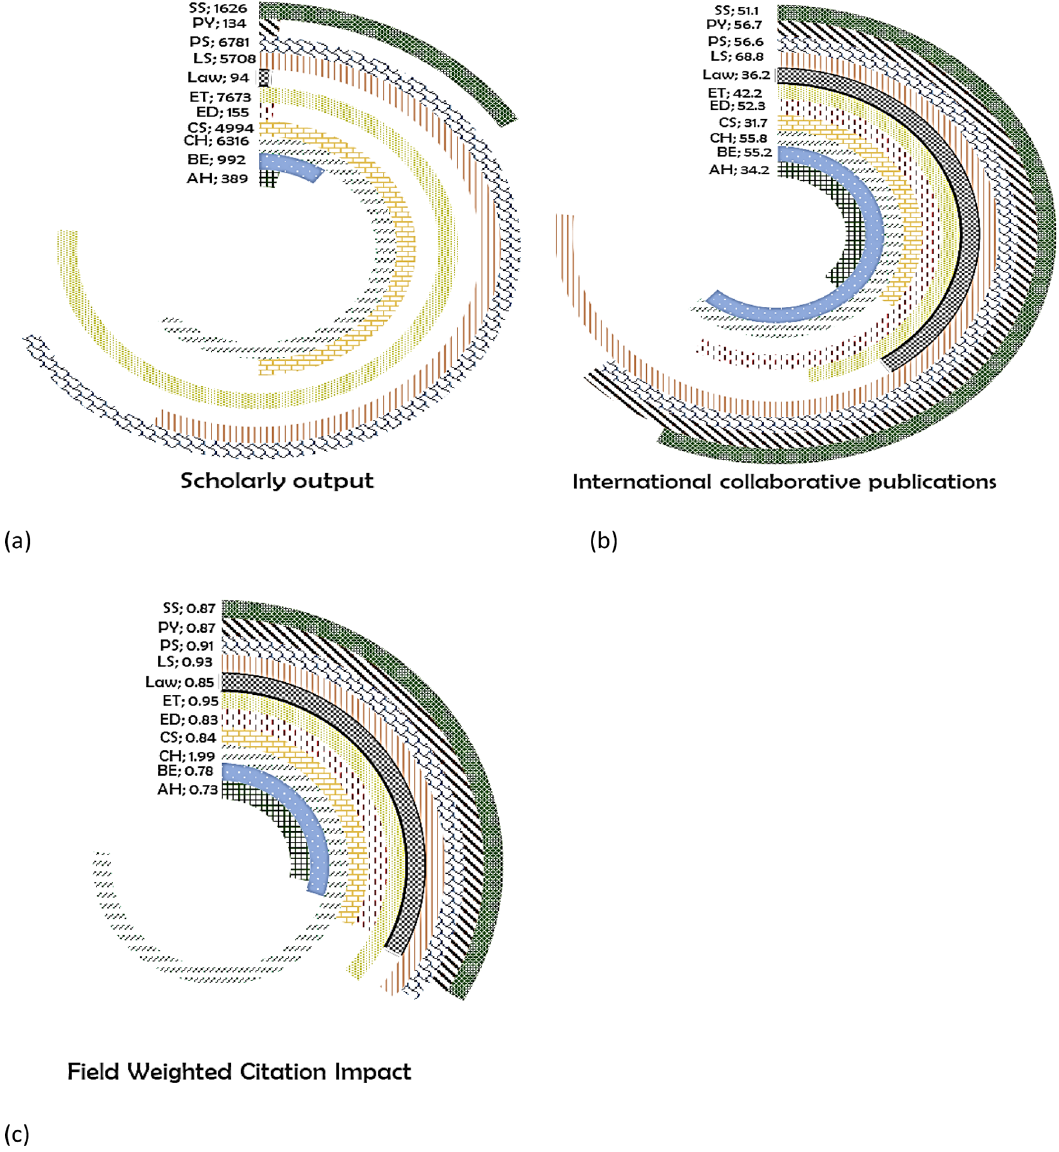
Figure 9. Subject wise split of Bangladesh research outcome (a) scholarly output, (b) International collabo- ration and (c) FWCI. Arts & Humanities (AH), Business and Economics (BE), Clinical, pre-clinical and health (CH), Computer Science (CS), Education (ED), Engineering and Technology (ET), Life Science (LS), Physical Science (PS), Psychology (PY), Social Science (SS).